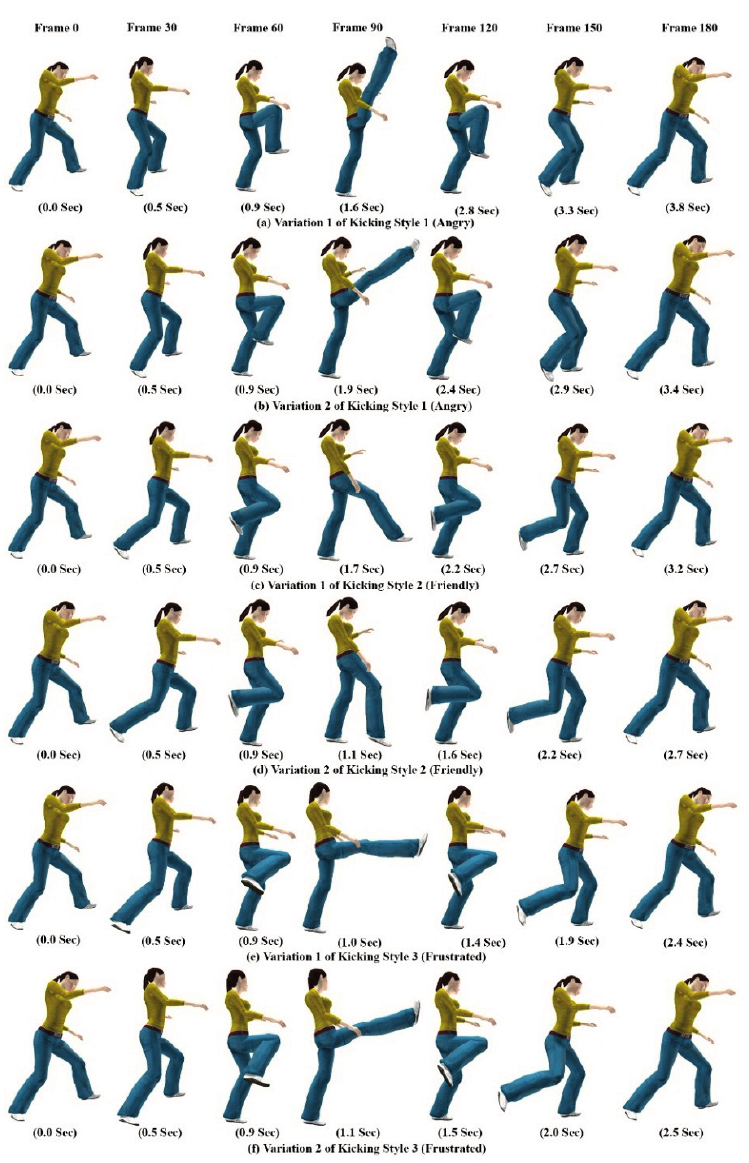
Figure 12. Spatial and temporal variations in kicking motions of